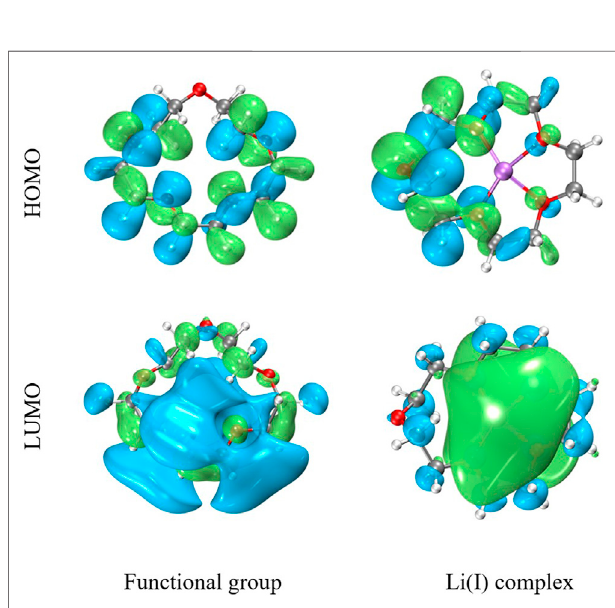
FIGURE 11 | The HOMO and LUMO of PAN-CE@SiO 2 /zeolite before and after adsorbing Li(I).